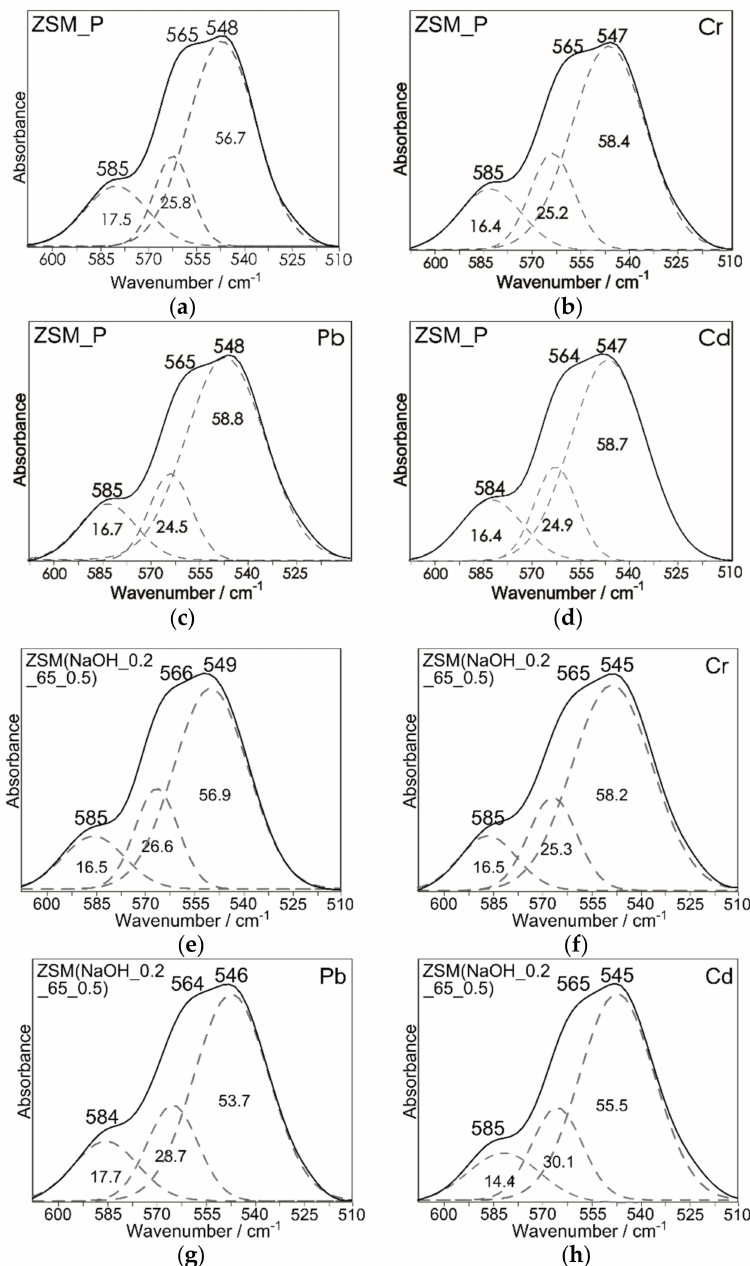
Figure 10. Decomposition of MIR spectra of ZSM_P and ZSM(NaOH_0.2_65_0.5) before ( a , e ) and after sorption of Pb 2 + ( c , g ), Cd 2 + ( d , h ) and Cr 3 + ( b , f ) ions from an aqueous solution (C 0 = 20 mmol / dm 3